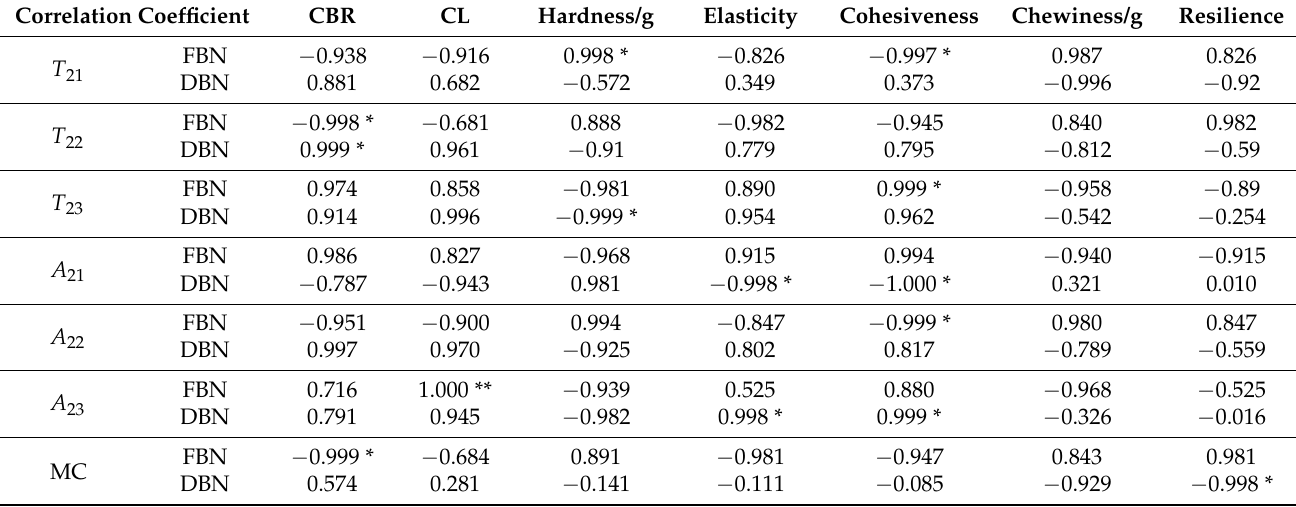
Table 5. Correlation analysis among different cooking characteristics of FBN and